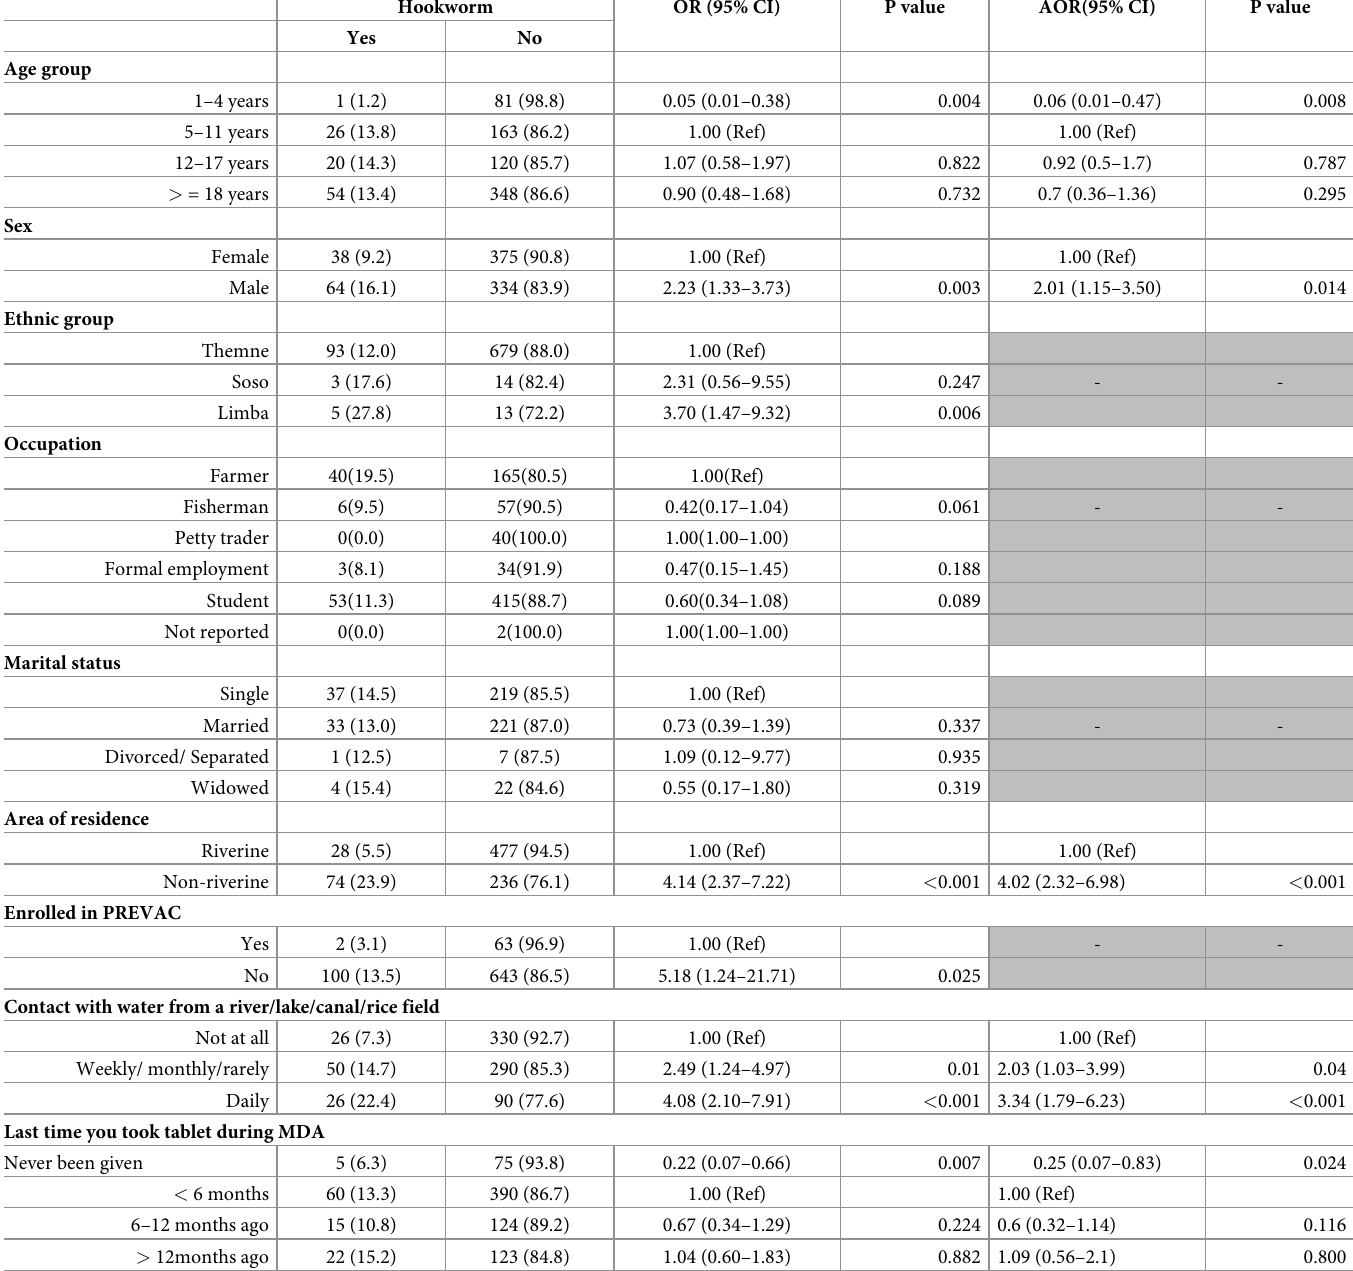
Table 4. Risk factors for hookworm infection in Mambolo